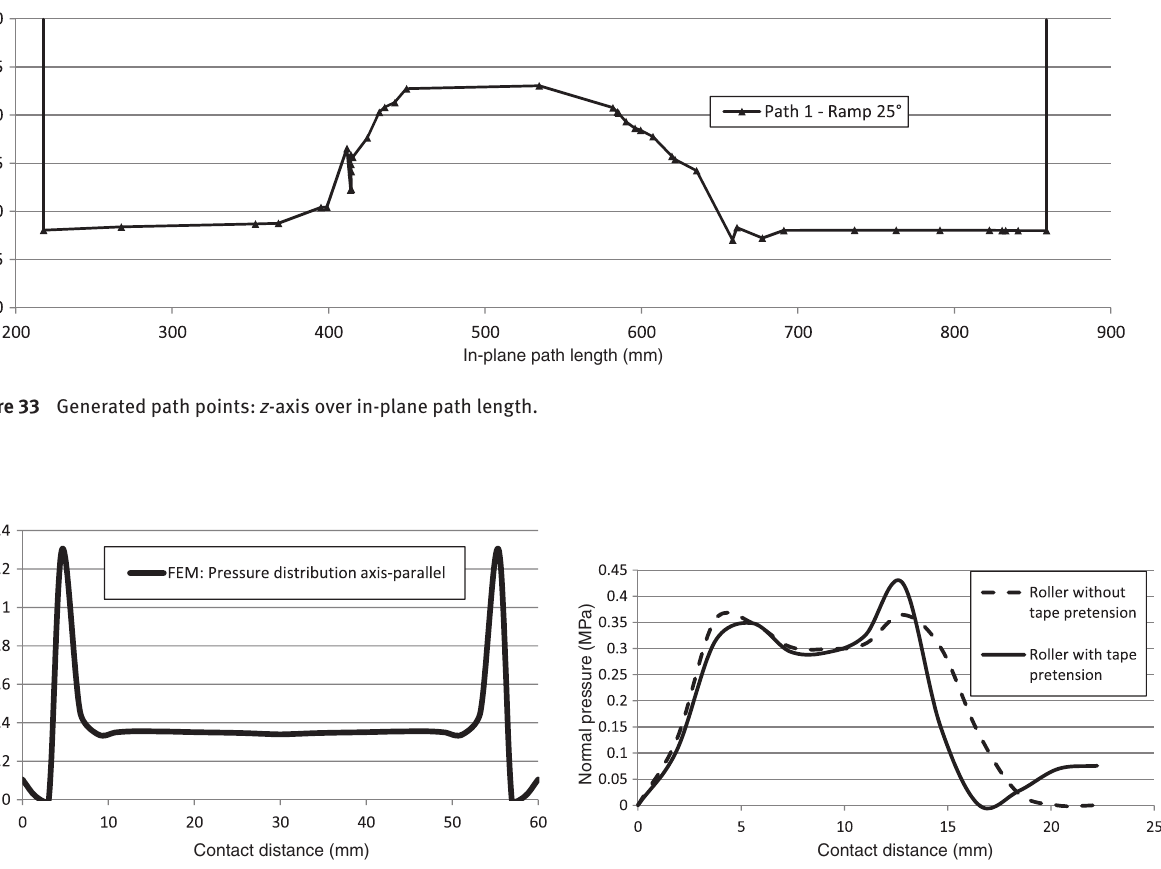
Figure 32 Surface mesh with generated paths.